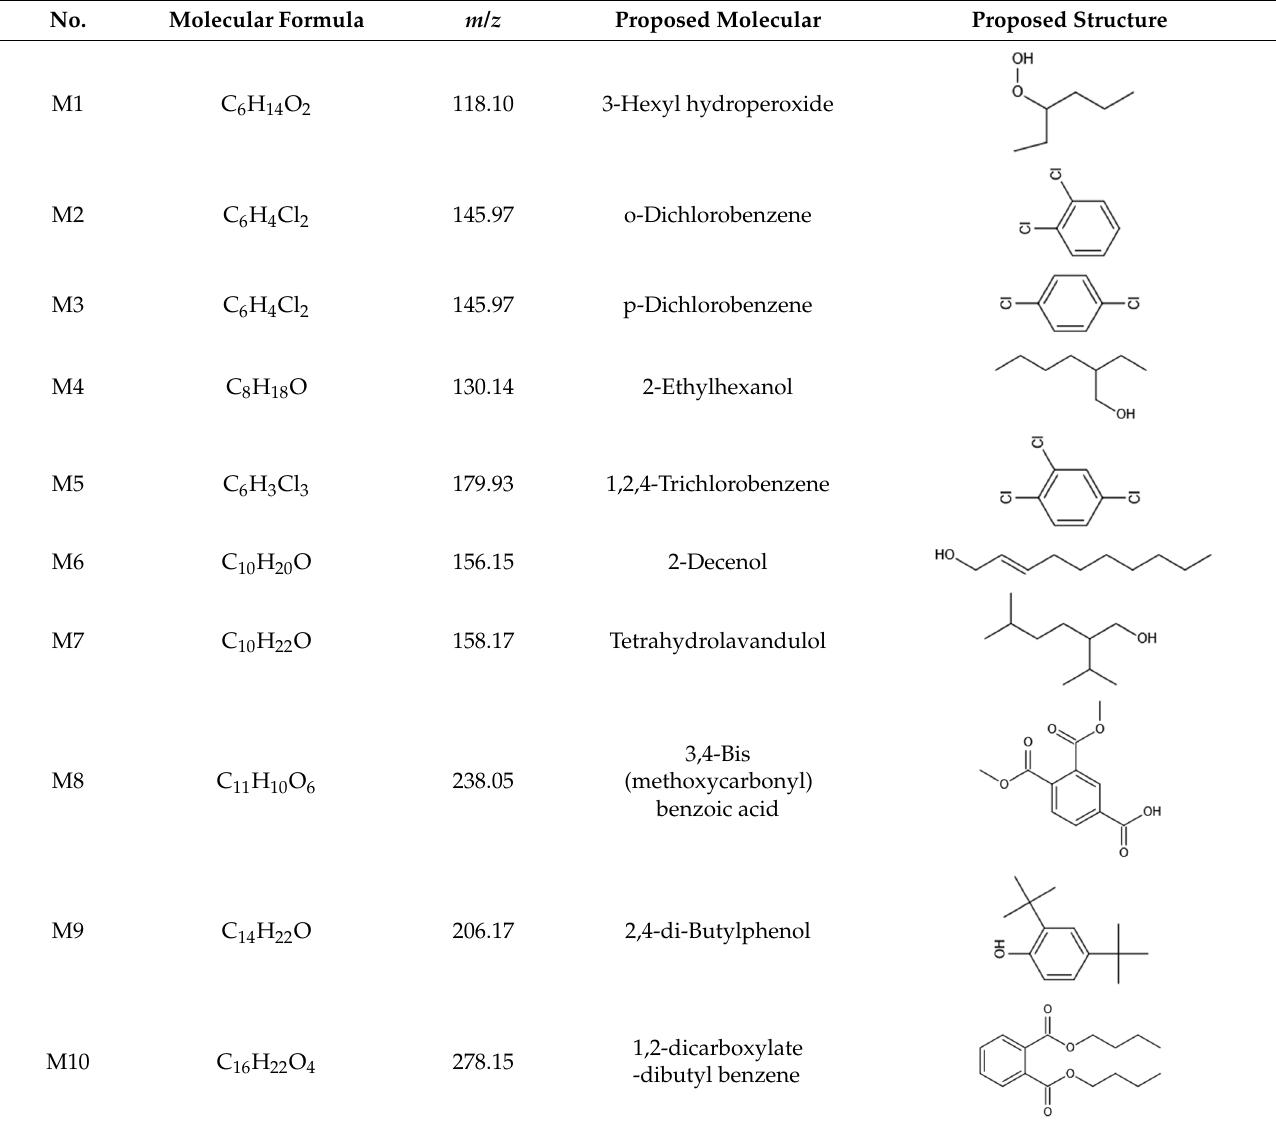
Figure 7. Chromatography of intermediate products of 1,2,4-TrCB degradation. The numbers M1 to M11 are the intermediate products corresponding to Table 1 . Table 1. Intermediate products of 1,2,4-TrCB.